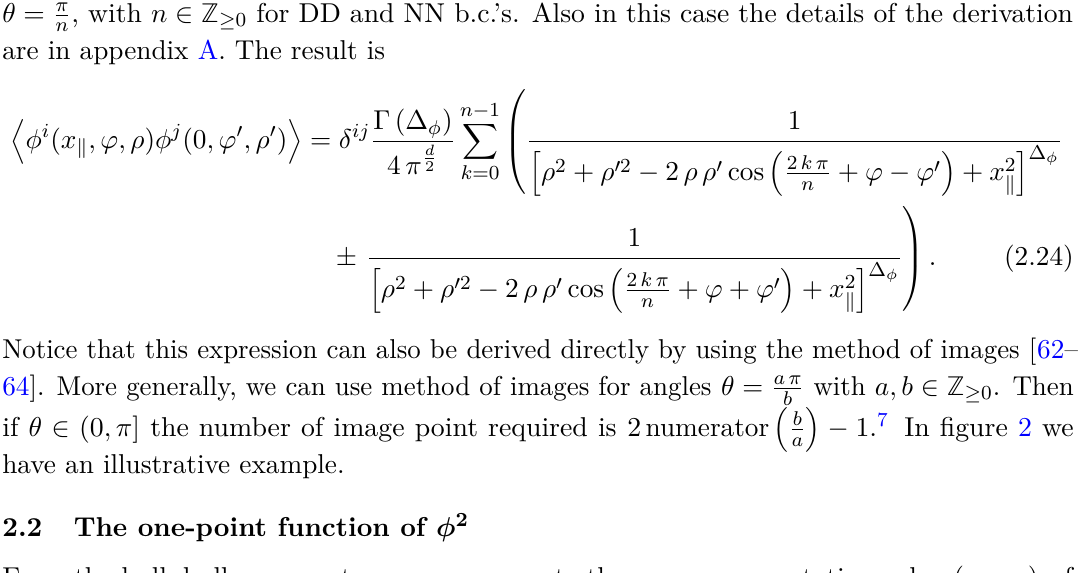
Figure 2 . The 15 image points (in red) required to solve the free theory DS equations for θ = 3 π The blue line is the wall, and the orange is the ramp. The dashed lines clarify how the bulk point (in black) is reflected through the two boundaries. All of the image points lie on a circle. θ = π case in generic d n